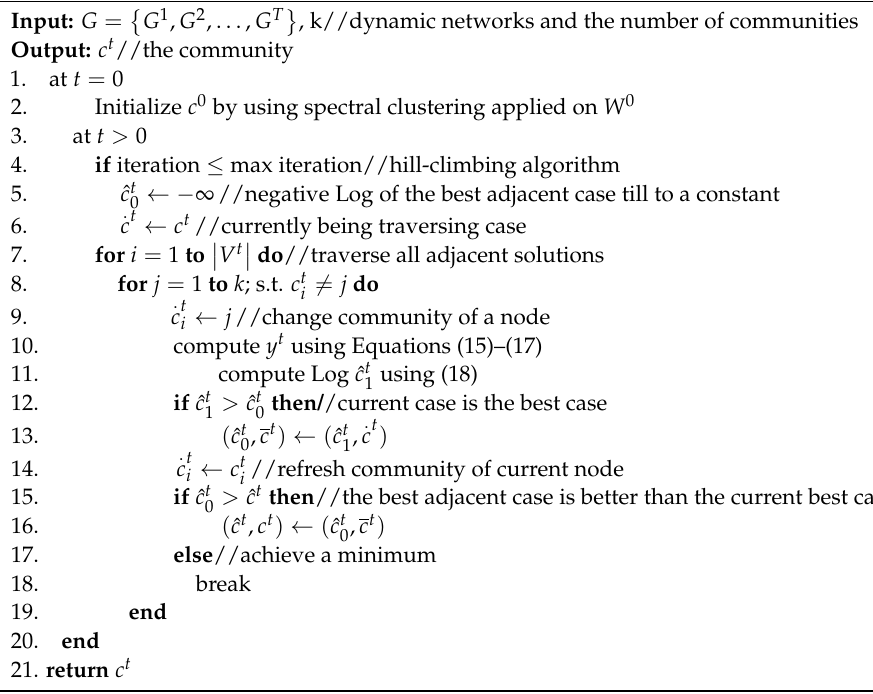
Algorithm 2 : The main procedure of